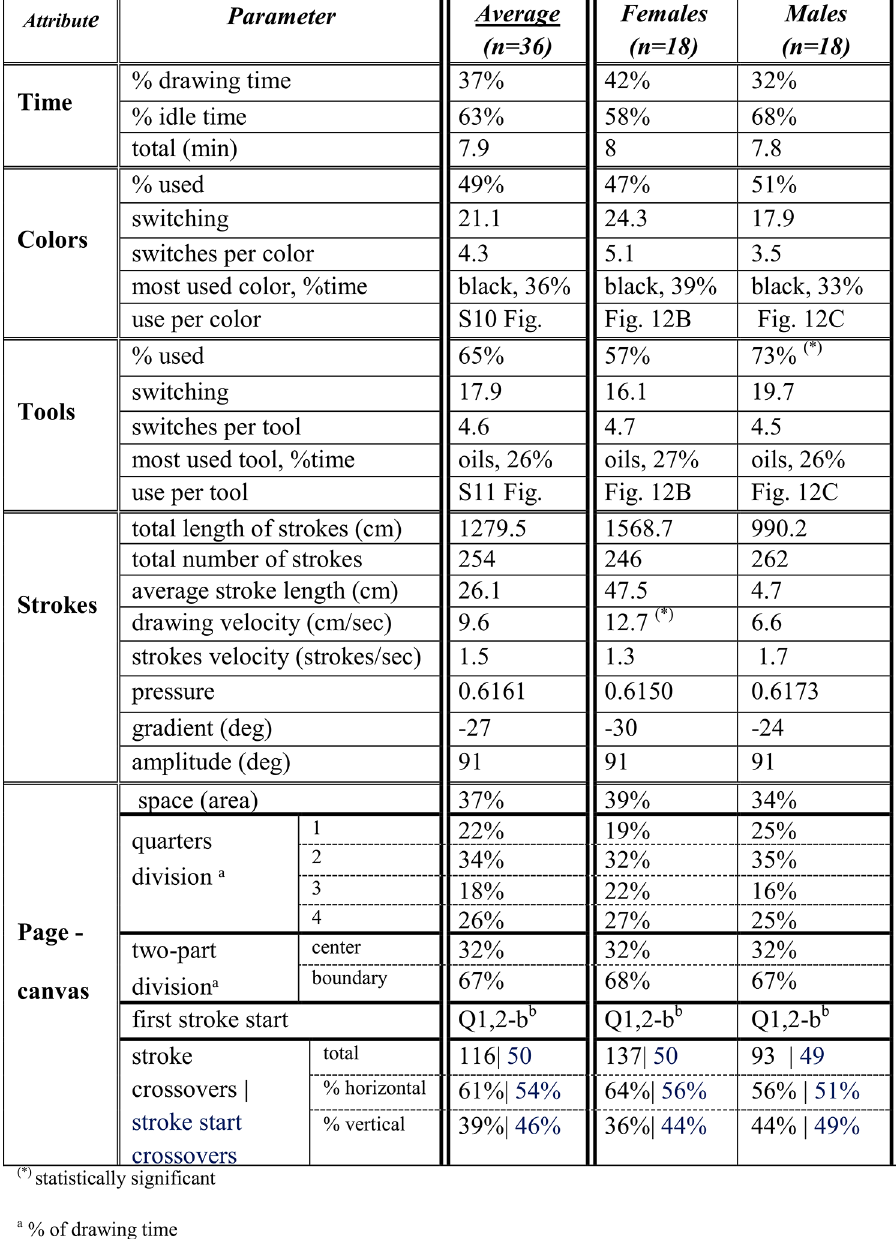
females ( p = 0.0157). This is consistent with the observation that females were busier drawing, since their velocity is almost 4-fold higher than males: 22.2 cm/sec vs. 6.3 cm/sec. found to be gender significant (right panel of Fig 12D), with that of females being almost twice longer than males: 5.1 cm for the females vs. 2.7 cm for the males ( p = 0.0171). Males used the